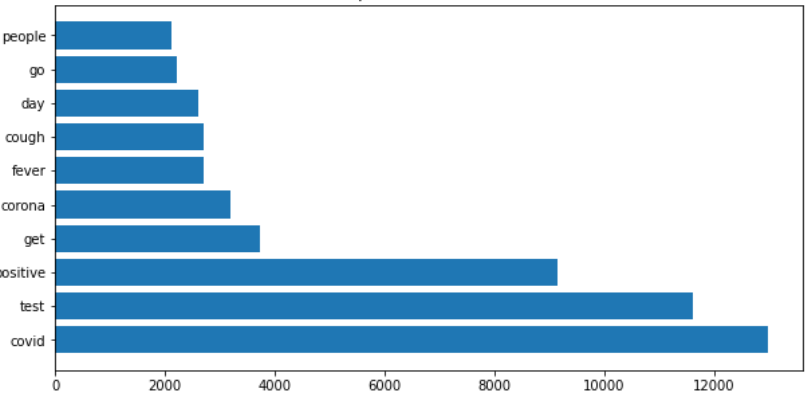
Figure 1. Most frequent words in dataset. Table 1. Words associated with the term covid .